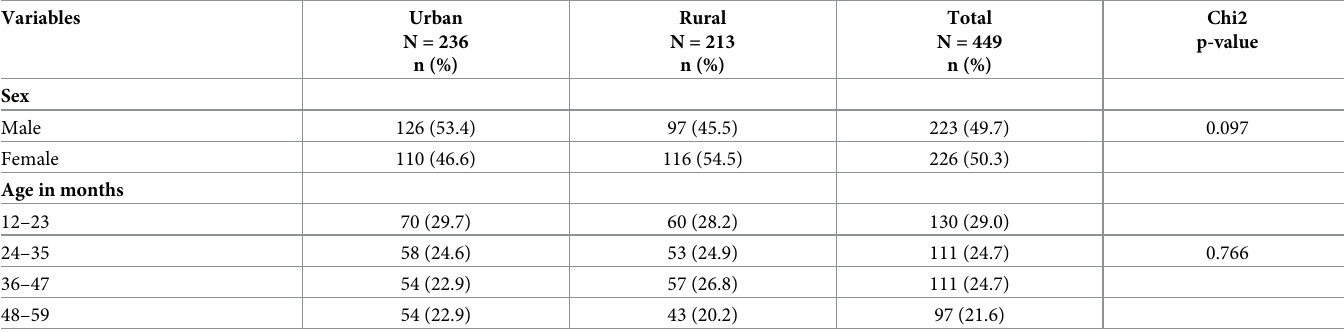
Table 2. Demographic characteristics of the children by location, Akinyele LGA, 2013.